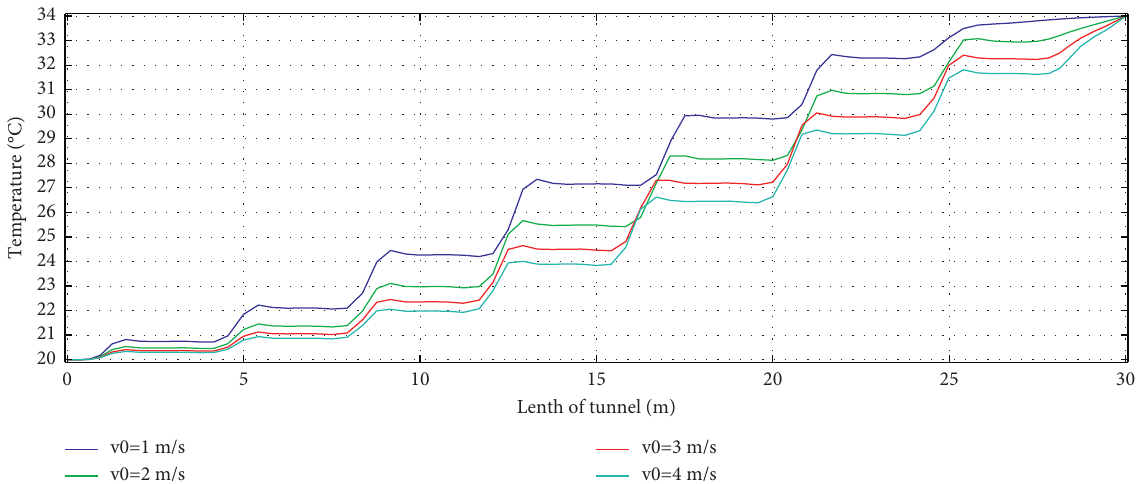
Figure 8: Air temperature distribution inside the tunnel at different wind speeds.